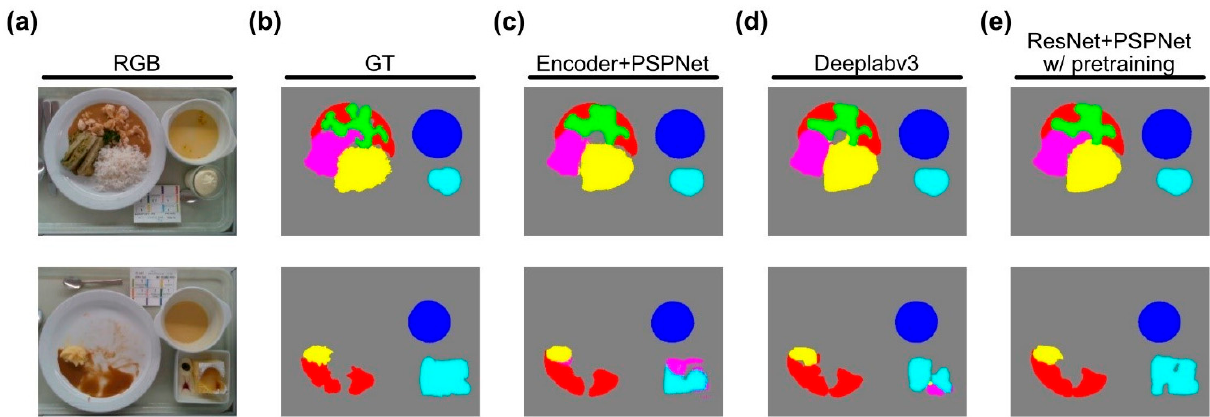
Figure 7. Segmentation results using different architectures: ( a ) the original RGB image; ( b ) the GT segmentation mask (GT seg ); ( c ) the segmentation mask from the Encoder + PSPNet; ( d ) the segmentation mask from DeepLabv3; ( e ) the segmentation mask from ResNet + PSPNet w/pretraining.